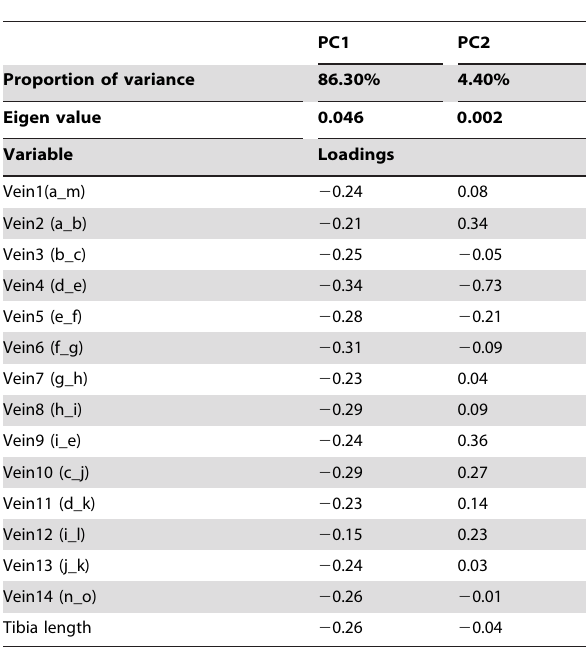
and B. oleae (68) (Table 3). Comparison of B. invadens populations against B. dorsalis sample gave a square distance of 11.4. The smallest distance was between the B. invadens populations and B.